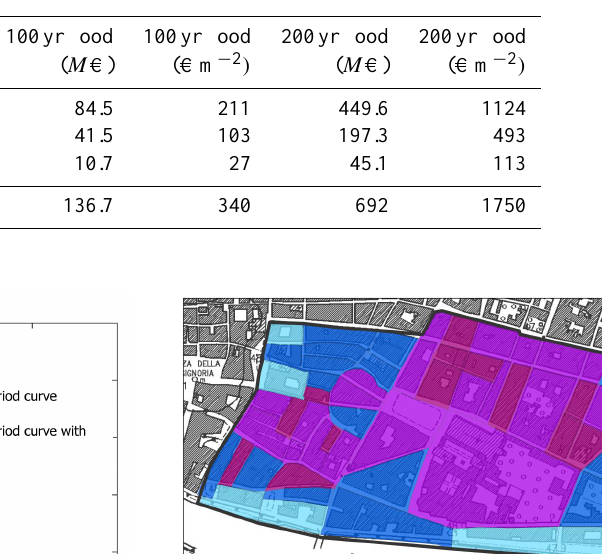
Table 3. Total damages and average damages for census unit surface in the study area.